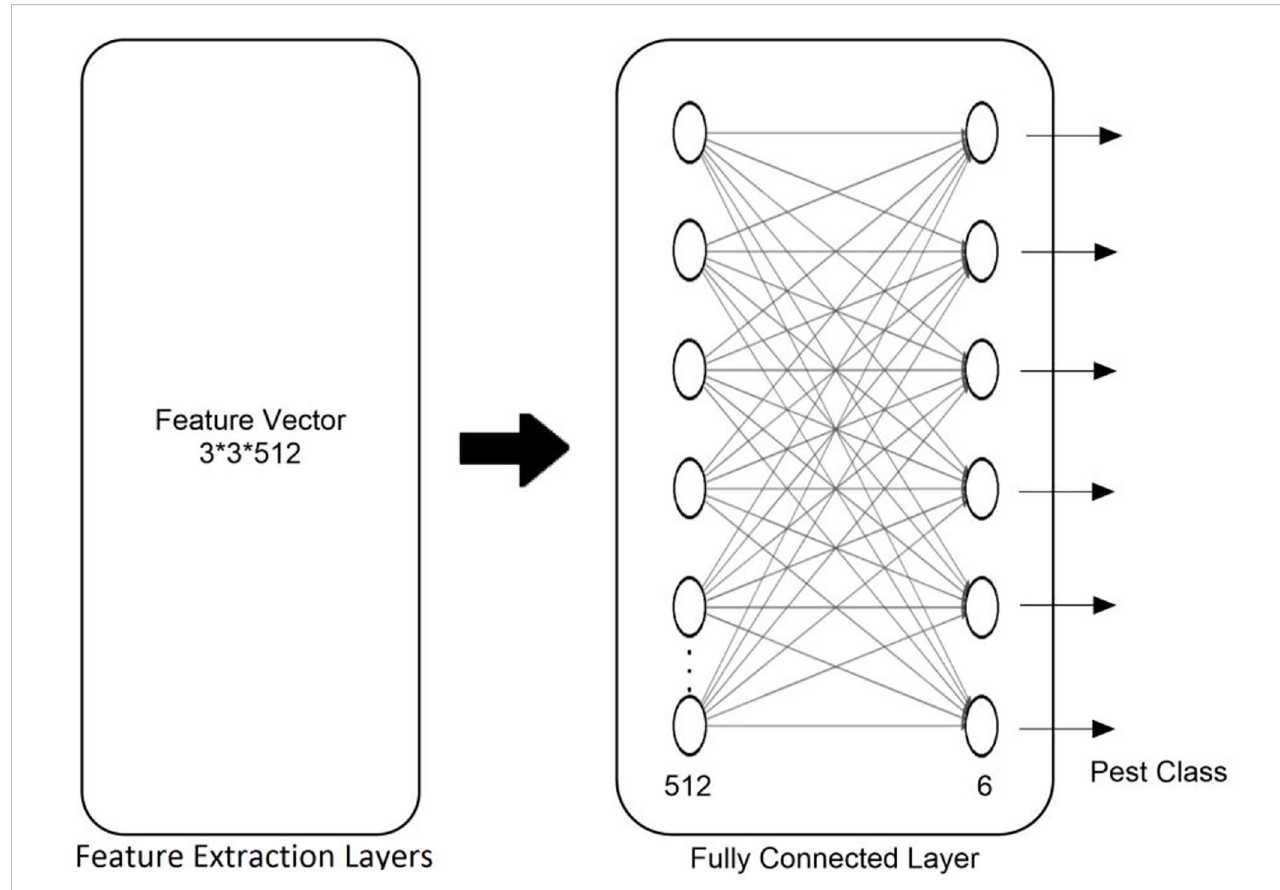
FIGURE 4 Modi fi ed FCL head of the machine vision